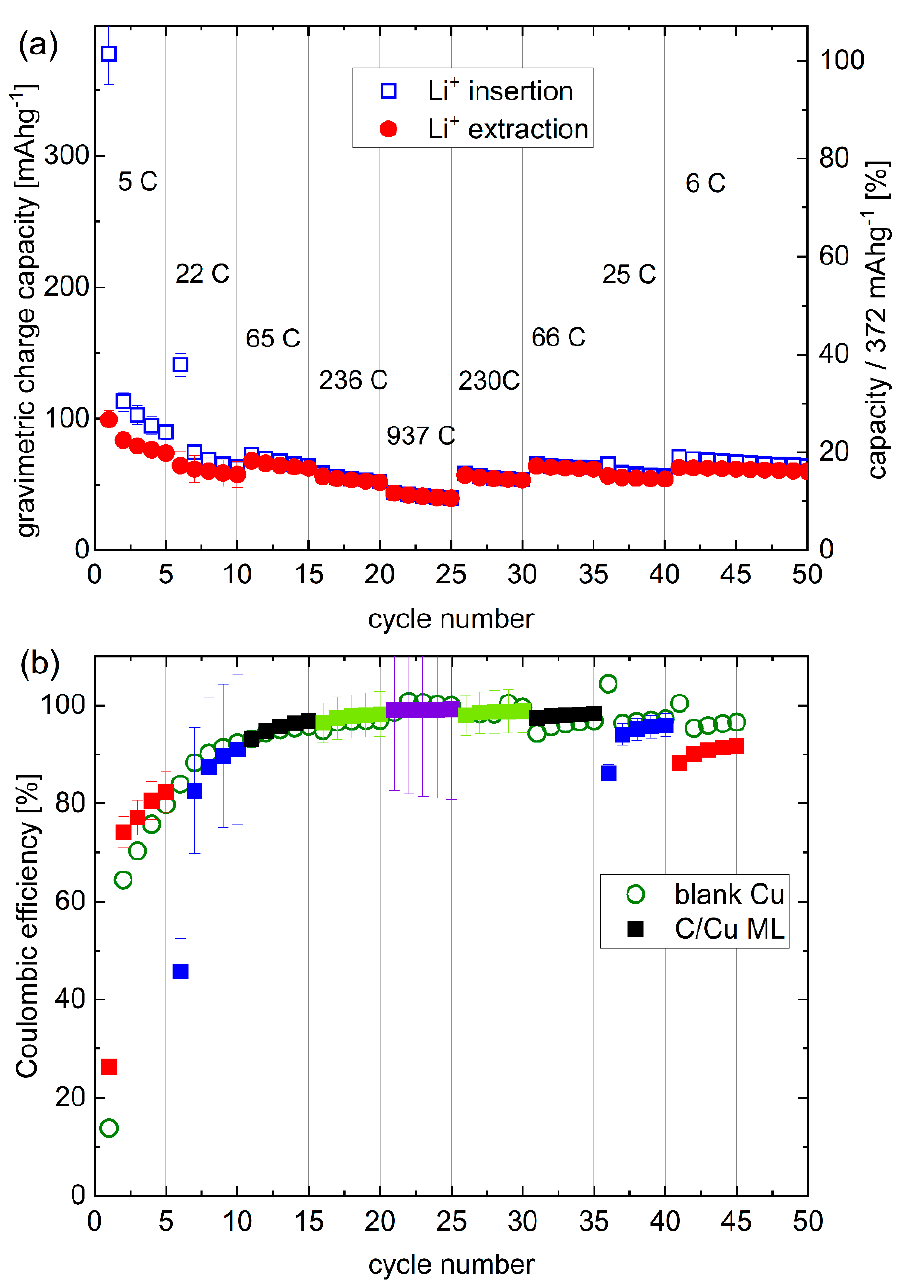
Figure 4. Rate capability: ( a ) Gravimetric capacity, and ( b ) Coulombic efficiency (CE) of the C/Cu ML electrode for the cycling inscribed in Figure 3. The CE of the C/Cu ML is plotted with filled squares. The different colors denote the different current densities (see Figure 3). The CE of the blank copper electrode is plotted with open circles. The rates are given for every fifth cycle. A color version of this figure can be viewed online.